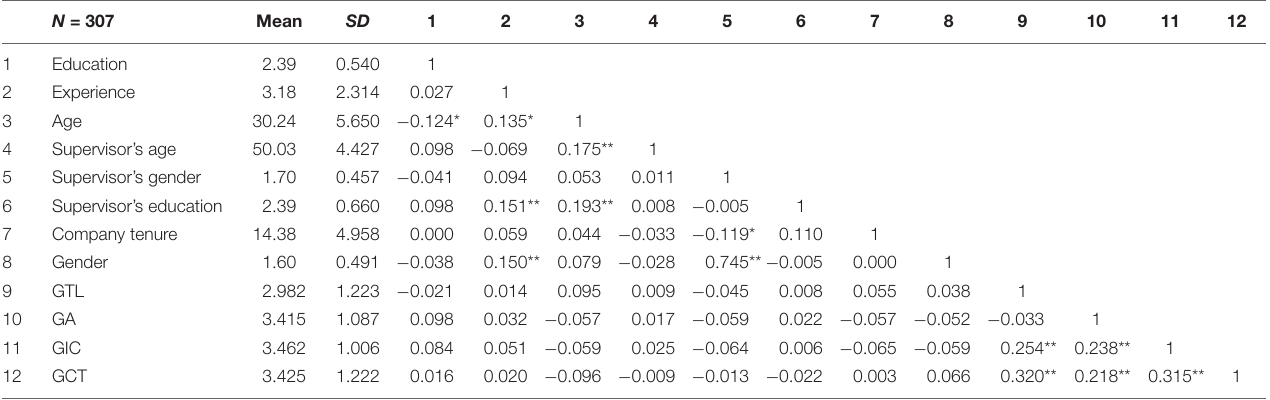
TABLE 2 | Means, SD, and correlation